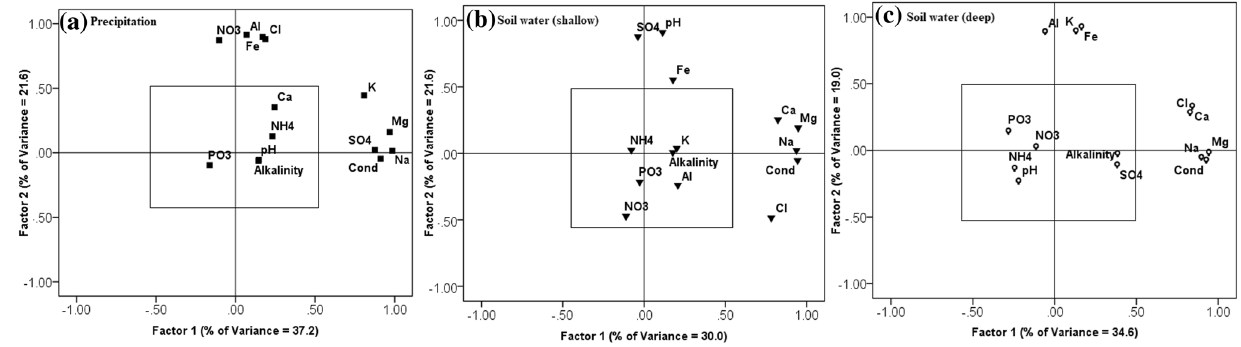
Fig. 4 PCA results showing the distribution of investigated parameters in the precipitation (P) and soil water (SSW and DSW; 0–10cm and below 10cm,